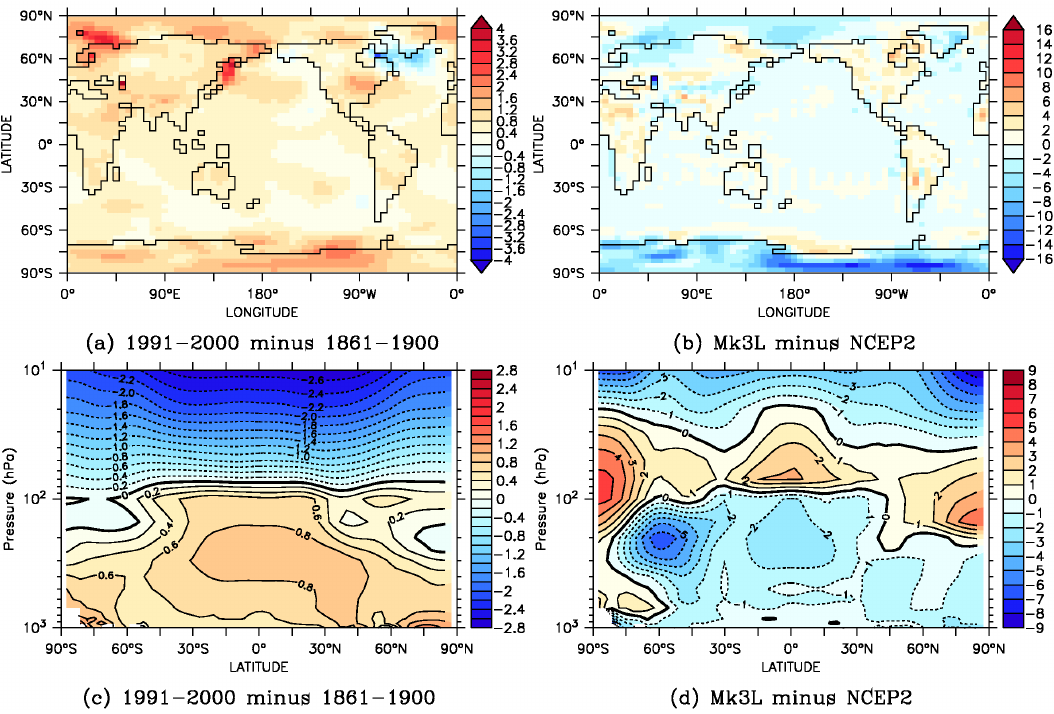
Fig. 16. The changes in atmospheric temperature (K) over the 20th century according to experiment LAST1000: (a) surface air tempera- ture, 1991–2000CE average minus 1861–1900CE average, (b) average surface air temperature for 1991–2000CE, Mk3L minus NCEP2, (c) zonal-mean temperature, 1991–2000CE average minus 1861–1900CE average, and (d) average zonal-mean temperature for 1991– 2000CE, Mk3L minus NCEP2.